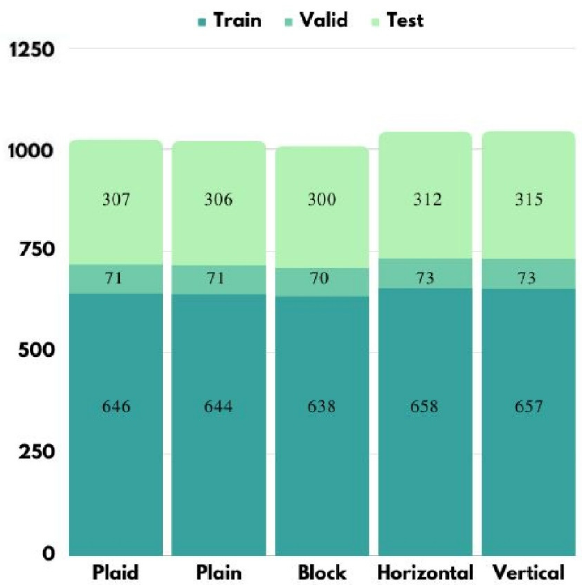
Figure 9. Image samples of each category in the process of training, validation, and testing.